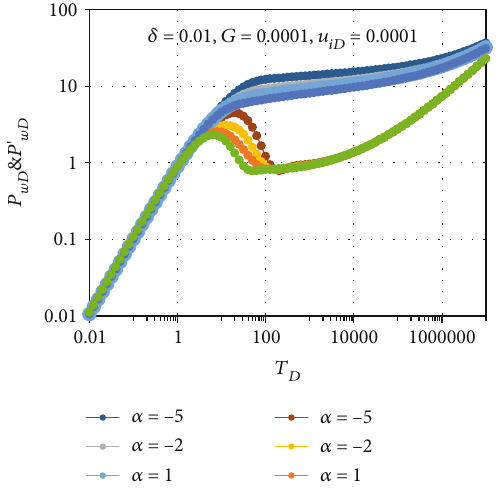
Figure 16: Typical curves under di ff erent degrees of mud pollution.